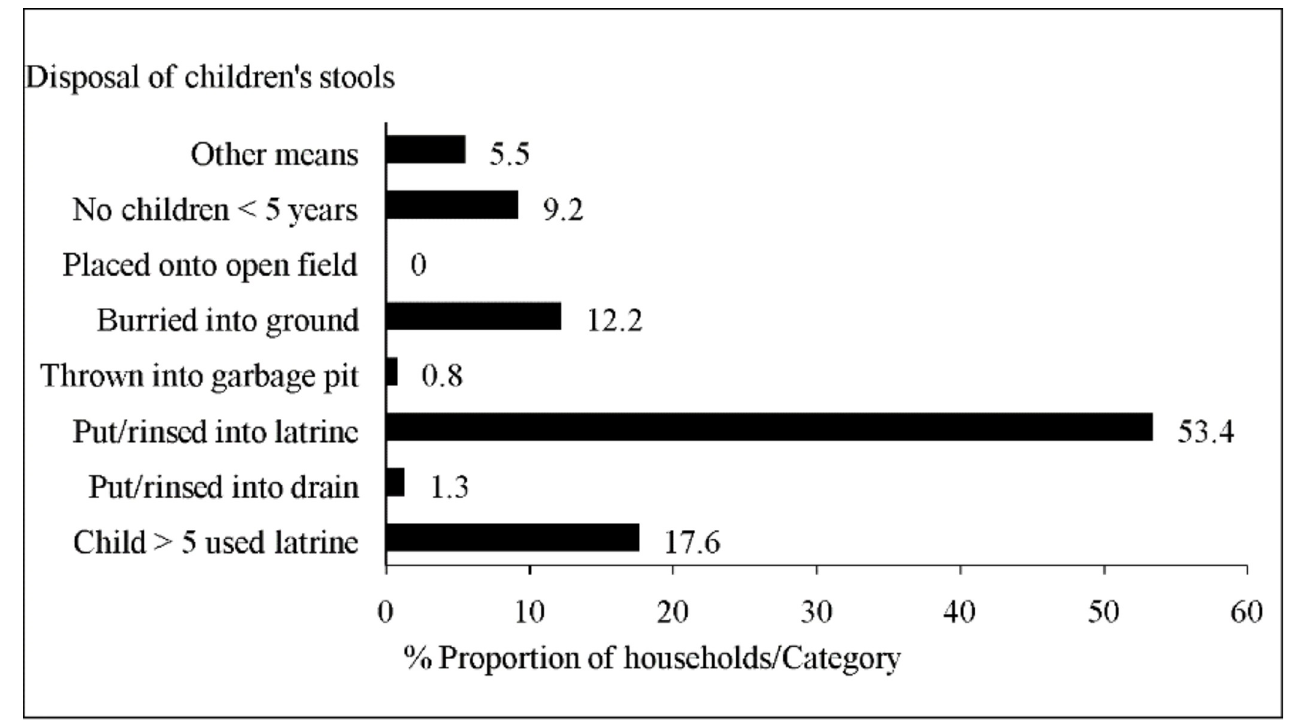
Fig 4. Safe disposal of children’s stools using the BVIP latrine in Mbire district, northern Zimbabwe, 2021 (n = 238).